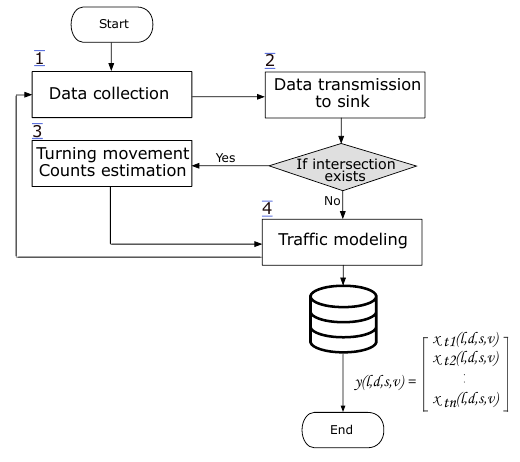
Figure 2. The system flow